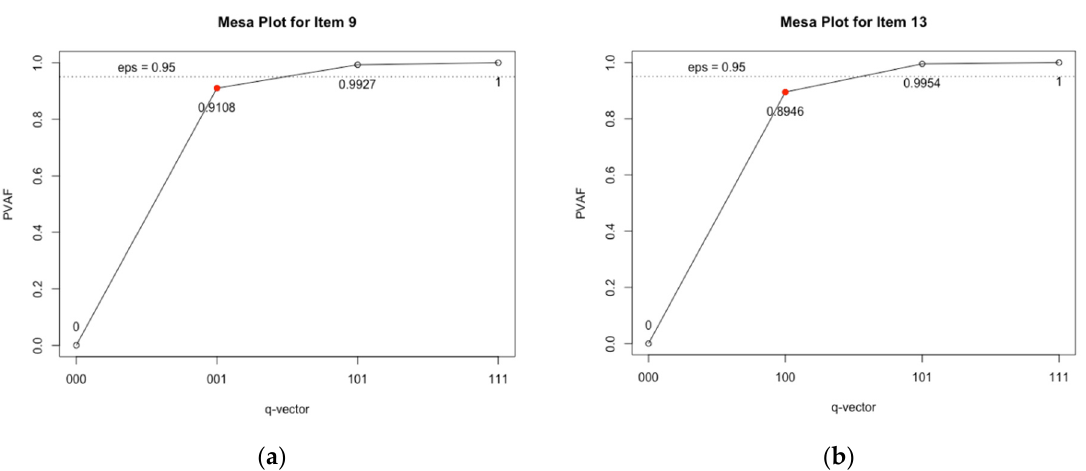
Figure 3. ( a ) Mesa plot for item 9; ( b ) Mesa plot for item 13.